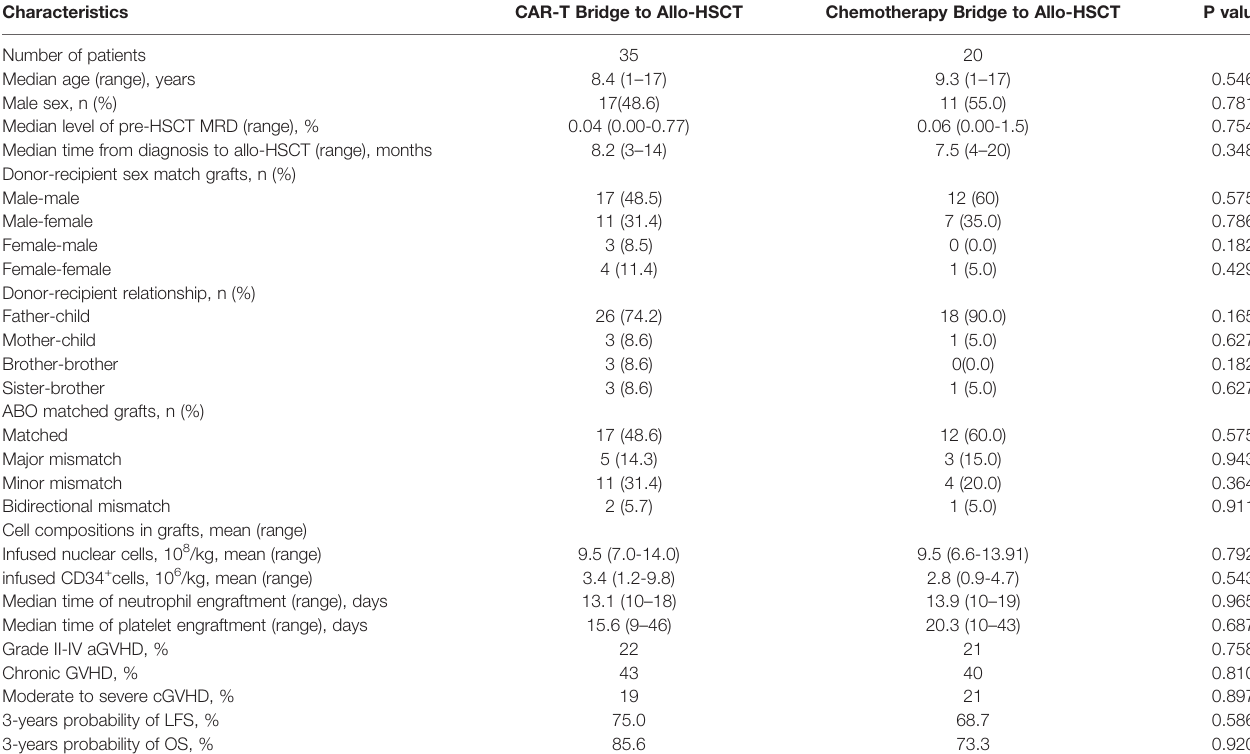
TABLE 2 | Characteristics of patients strati fi ed by CAR-T bridge to allo-HSCT and chemotherapy bridge to allo-HSCT.